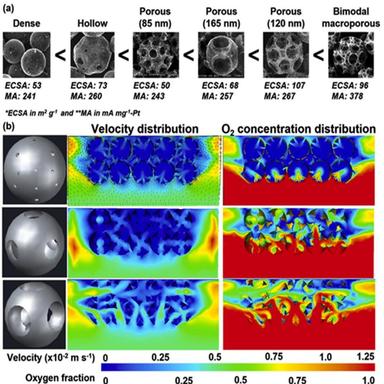
Catalytic activity enhancements of nanostructured Pt/C catalysts.62 64 and (b) Velocity distribution profiles in catalysts with different pore sizes. Reprinted (adapted) with permission from (AIChE Journal 2016; 62; 440–450). Copyright © 2016 Wiley).